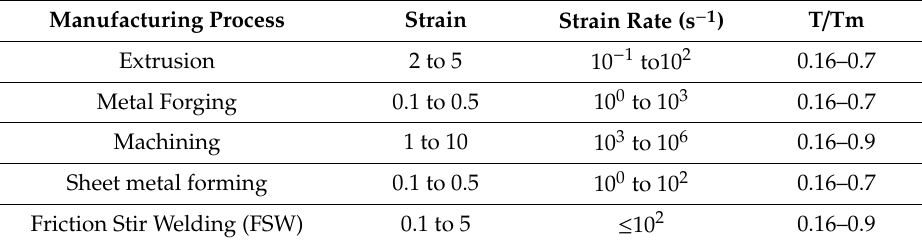
Table 1. Typical strains, strain rates, and temperature ratio (T / Tm) of some manufacturing processes also given by [5]. (T = Temperature during the process, Tm = melting temperature of the